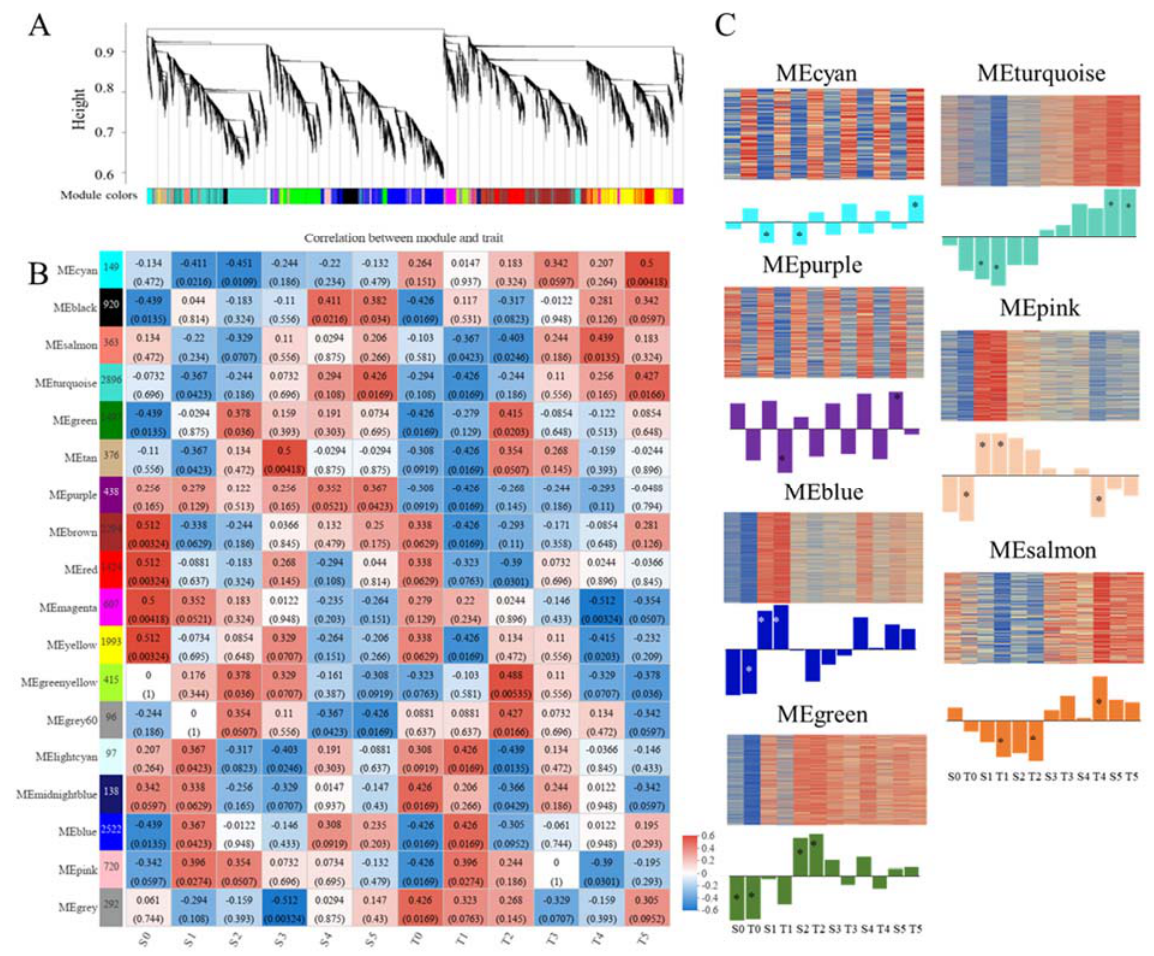
Figure 5. Hierarchical clustering tree of DEGs based on co-expression network analysis in the Cd-sensitive and Cd-tolerant varieties ( A ), eigengene–trait correlation analysis ( B ), and expression patterns of the co-expressed genes in hub modules ( C ). Numbers on the heatmap represent correlation coefficients, and numbers less than 0.05 in parentheses indicate significant correlations. * represent significant